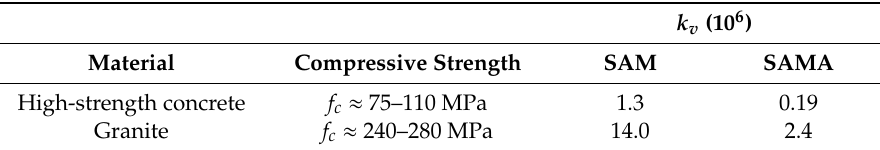
Table 6. Recommended abrasion coe ffi